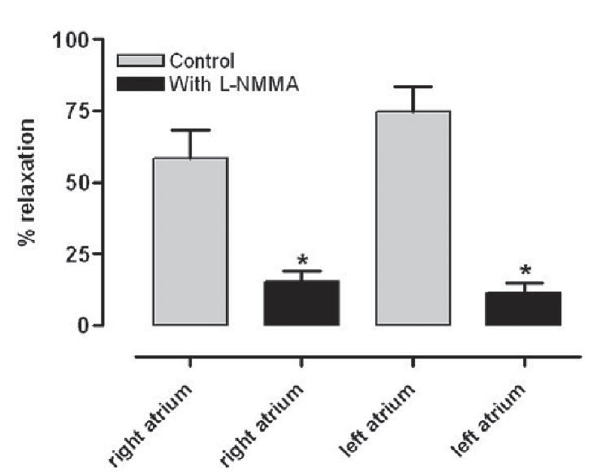
Fig. 3 - Bioassay of calcium ionophore-induced promote relaxation in the right and left atrium. The vasodilator activity of effluent from the right and left atrium was blocked 85.1 + 7.9% and 88.9 + 3.5%, respectively by the presence of the L-NMMA (10- 4 M) in rings contracted with PGF (2x10 -6 M). Results are reported as 2 α means + SEM. * indicate significant difference between with and without L-NMMA groups (P < 0,001)